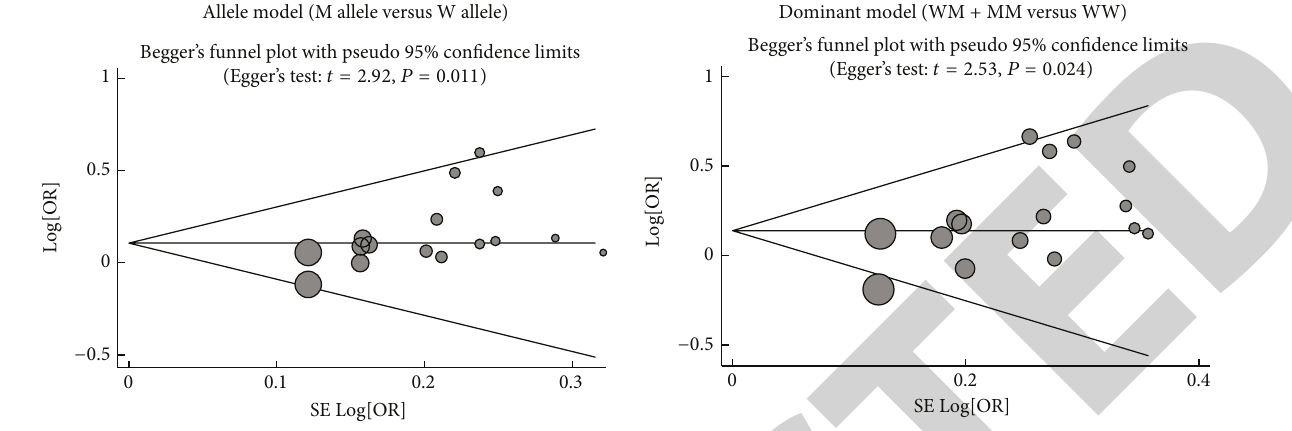
Figure6:Begger’sfunnelplotofpublicationbiasesontherelationshipsof VEGF geneticpolymorphismswiththeriskofdiabeticnephropathy in patients with diabetes mellitus under the allele and dominant